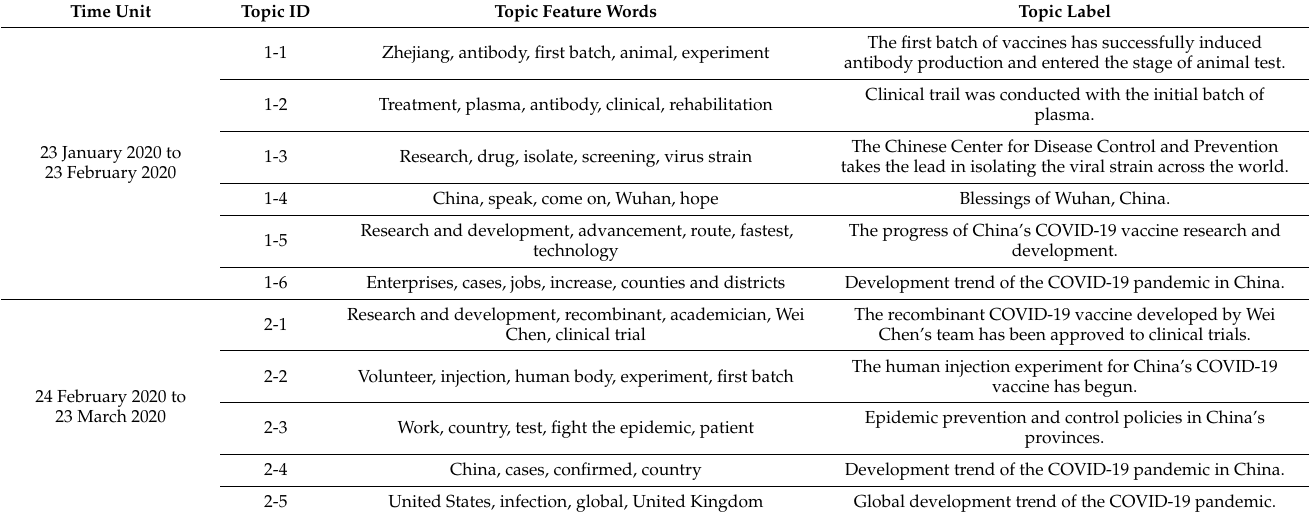
Table A1. Results of feature words extraction and topic